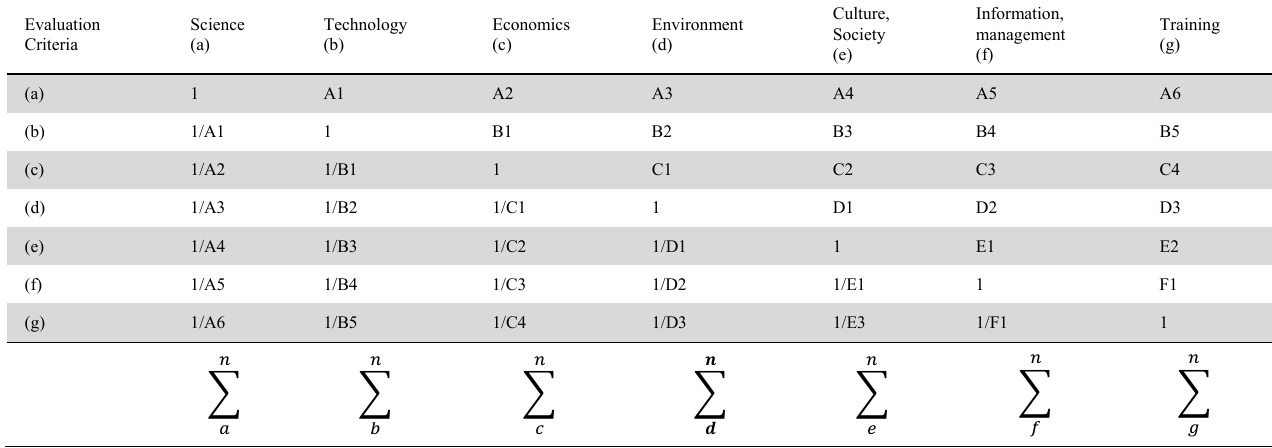
Matrix of criteria according to experts’ opinion and weights Evaluation Criteria